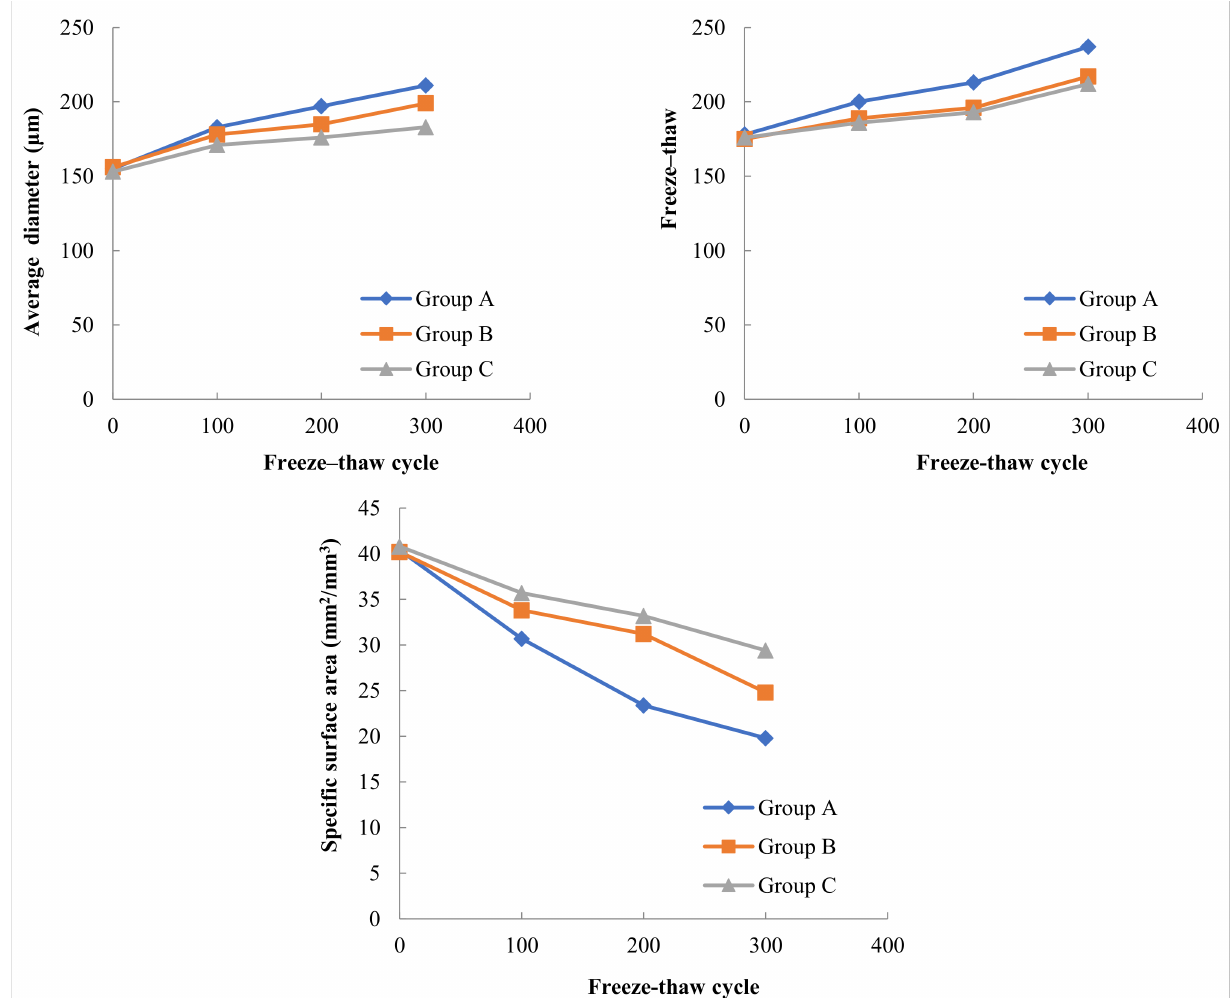
Figure 10. Variation of air void parameters for concrete with different internal water content ( − 40 ◦ C freezing